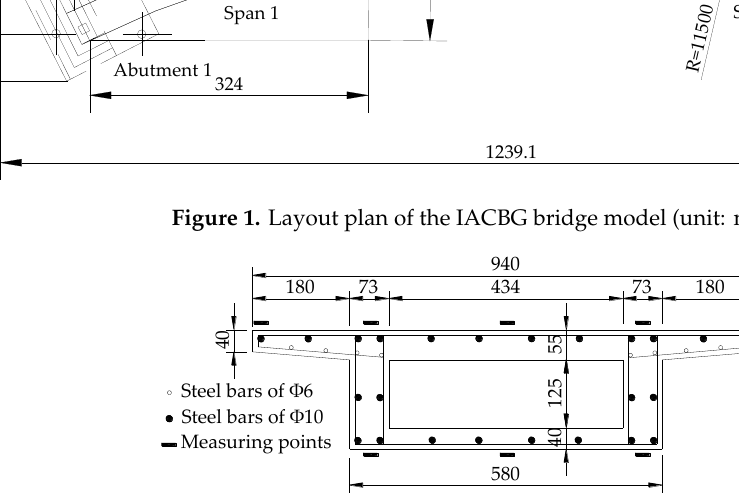
Figure 2. Shape and sizes of the cross section (unit: mm).